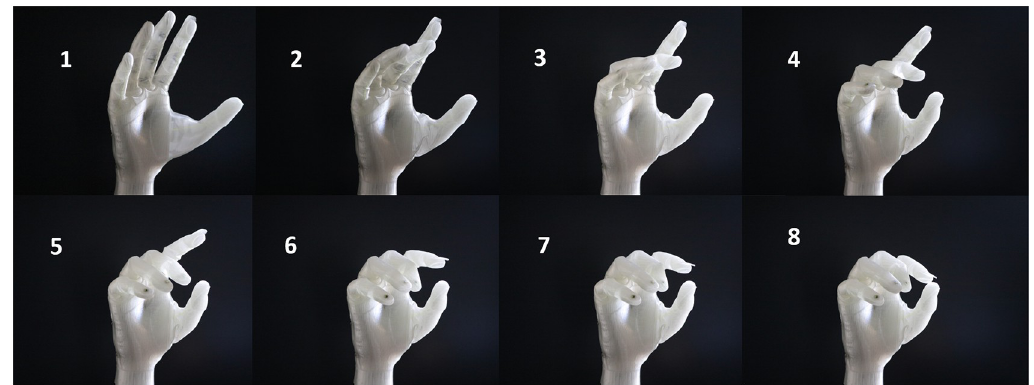
Fig 13. Synergy of fingers for performing pinch